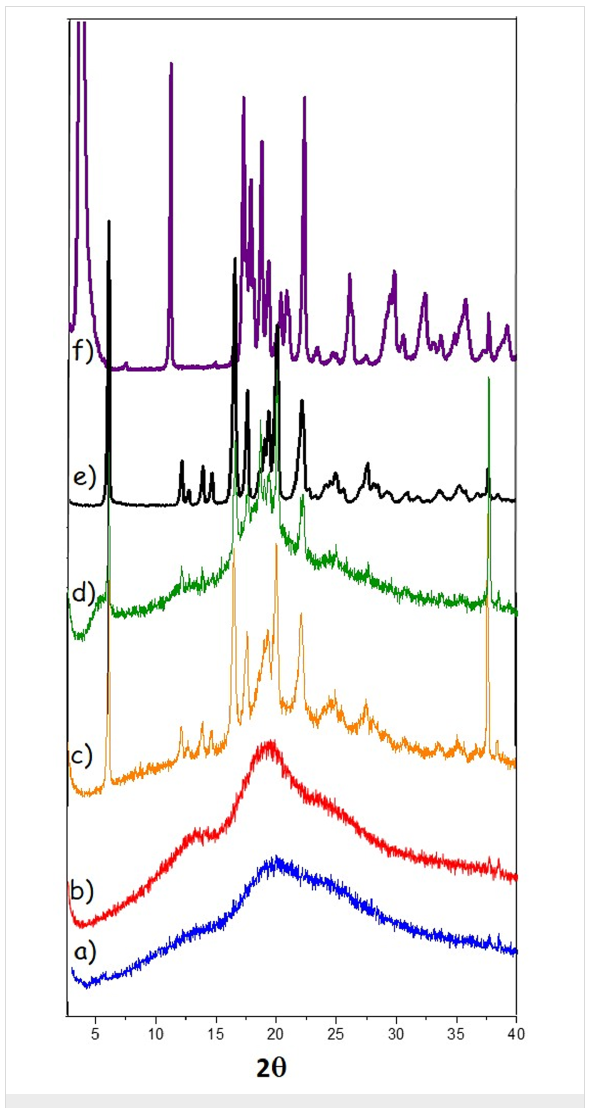
Figure 10: PXRD patterns of: a) CDNS(1:8), b) CDNS(1:4), c) CDNS(1:8)-IbuNa loaded, d) CDNS(1:4)-IbuNa loaded, e) IbuH, an- alytical standard, f) IbuNa, analytical standard, The notation CDNS- IbuNa indicates the original preparation, irrespective of the conversion of the sodium salt into the undissociated